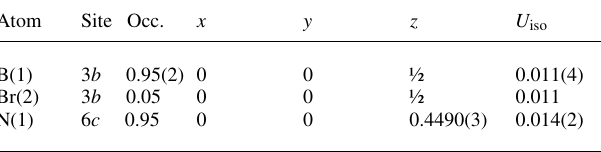
Table 4. Atomic coordinates and displacement parameters (in Å 2 ) for the composition Eu 2 [BN 2 ] 1 − x Br 1+ x with x = 0.05(2) . Atom Site Occ.